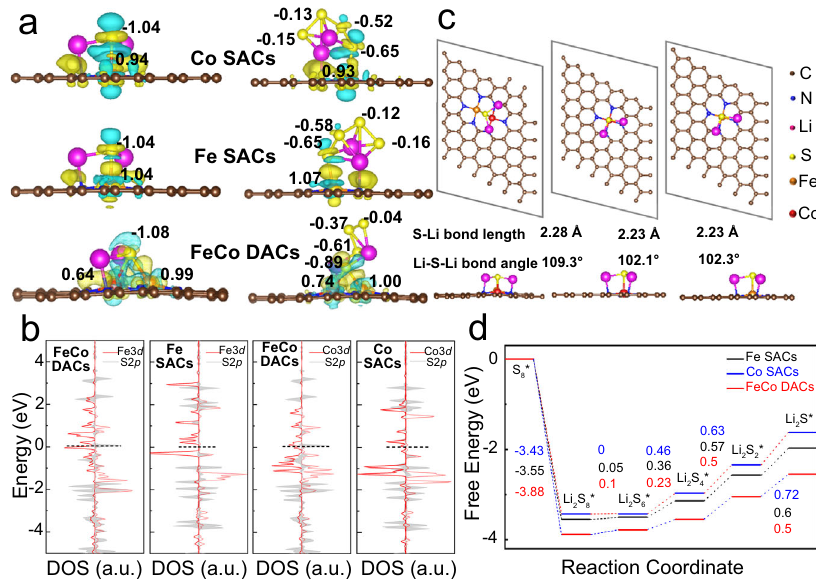
Fig.7|DFTcalculationsofFe-CoDACs,FeSACsandCoSACscatalysts.a Charge density difference plot of Li 2 S (Left) and Li 2 S 4 (Right) adsorbed on different materials. b DOS of Li 2 S 4 adsorbed on Fe-Co DACs, Co SACs and Fe SACs systems.